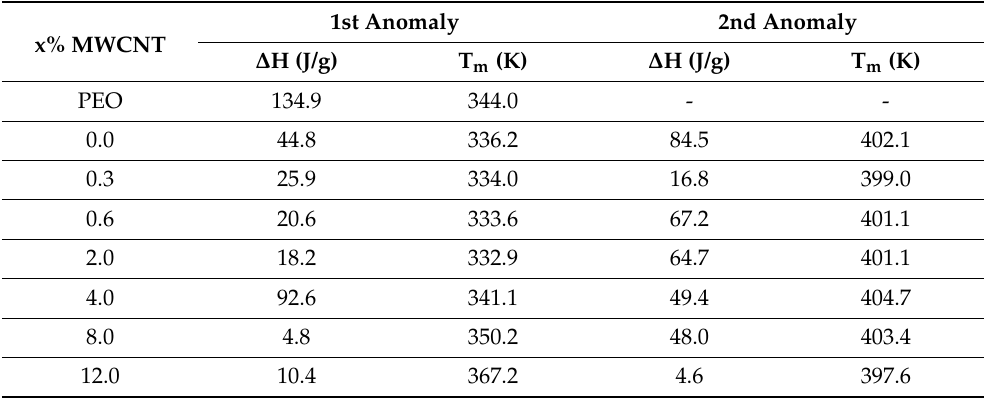
Table 5. Enthalpies ( ∆ H) and melting temperatures (T m ) for the first and second endothermic anomalies in DSC heating sweeps.